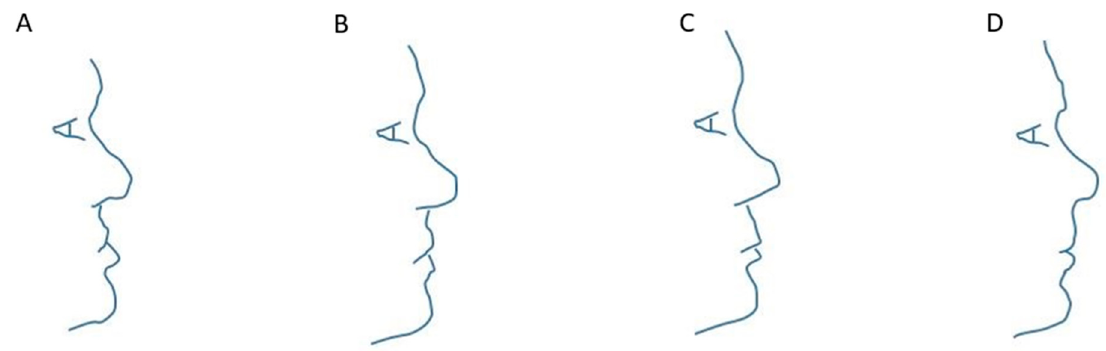
Figure 2. Profile images of a patient with Class III malocclusion, treated with orthognathic surgery: ( A ) pre-treatment; ( B ) simulation from Dentofacial Planner Plus (DFP); ( C ) simulation from Dolphin Imaging (DI); ( D ) actual post-operative photograph [14].